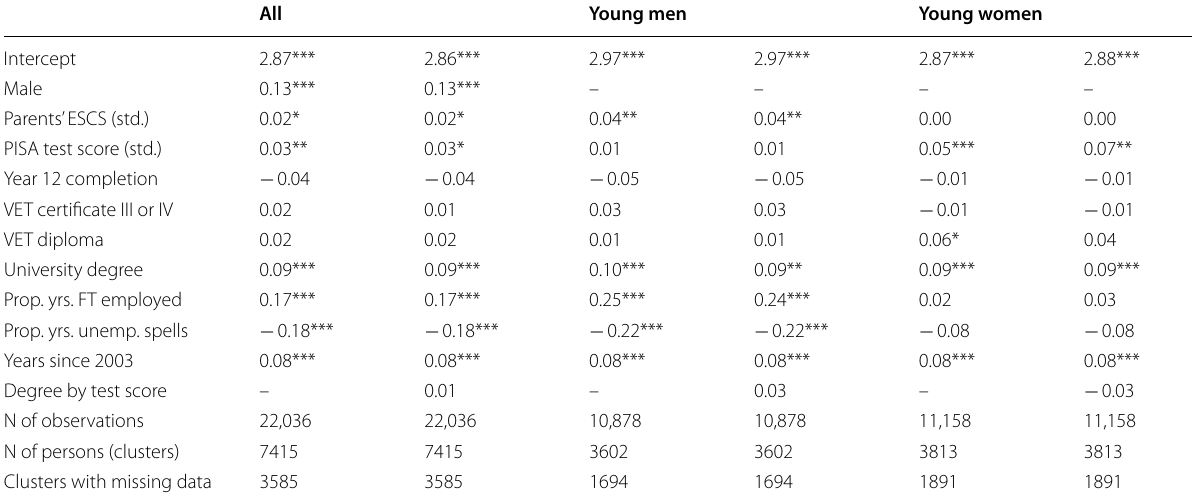
Logged regression coefficients from repeated design analyses. Full-time study observations excluded. Weighted for sample selection and attrition. See Table 1 for abbreviations